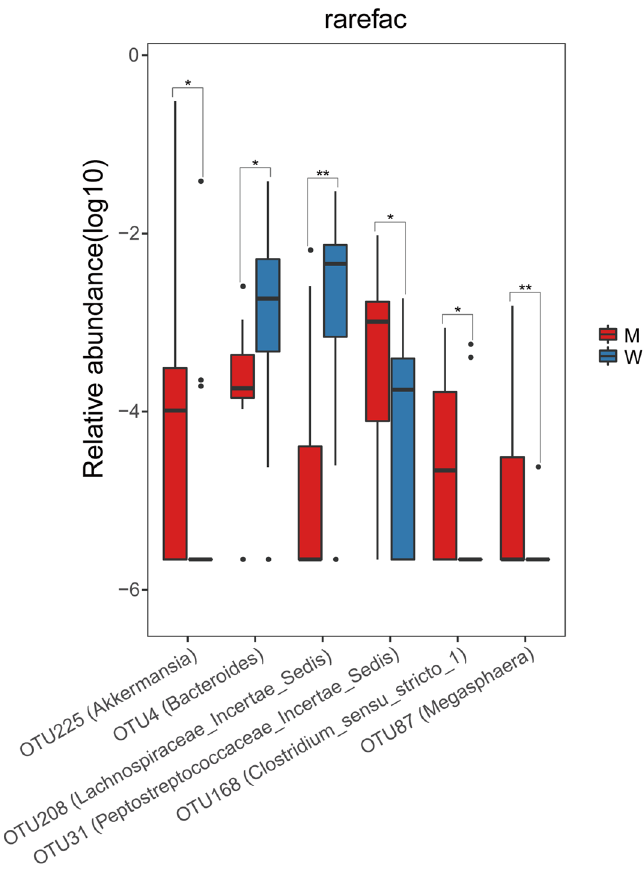
Figure 3. Different abundant bacteria on OTU level between the M and W groups of the CAPD patients. W well-nourished group, M malnourished group.